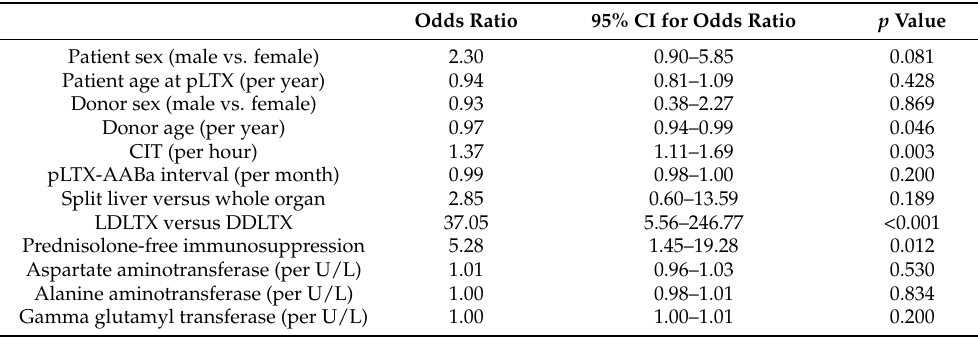
Table 2. Characteristics associated with SMA titer > 1:20 (odds ratios from binary logistic regression, mutually adjusted for all variables in the model, n =